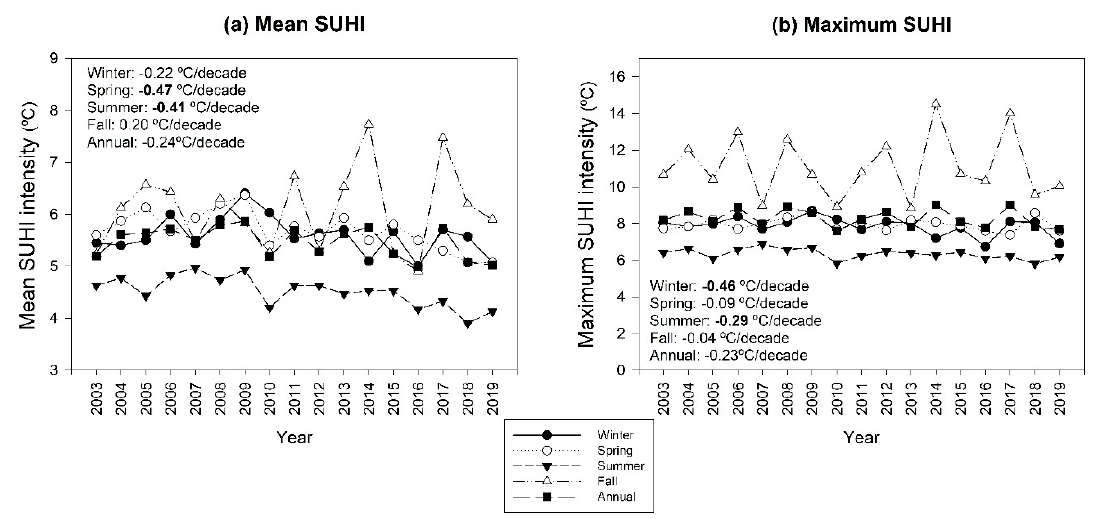
Figure 2. Seasonal and annual variability of mean ( a ) and maximum ( b ) surface urban heat island (SUHI) intensity over Greater Cairo between 2003 and 2019. Amount of change in the intensity of SUHI is provided; only numbers given in bold are statistically significant at the 95% confidence interval ( p < 0.05).